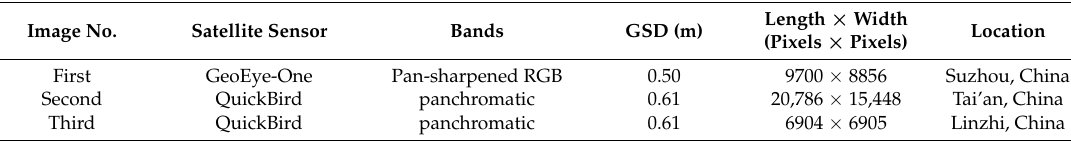
Table 1. Information about the three test